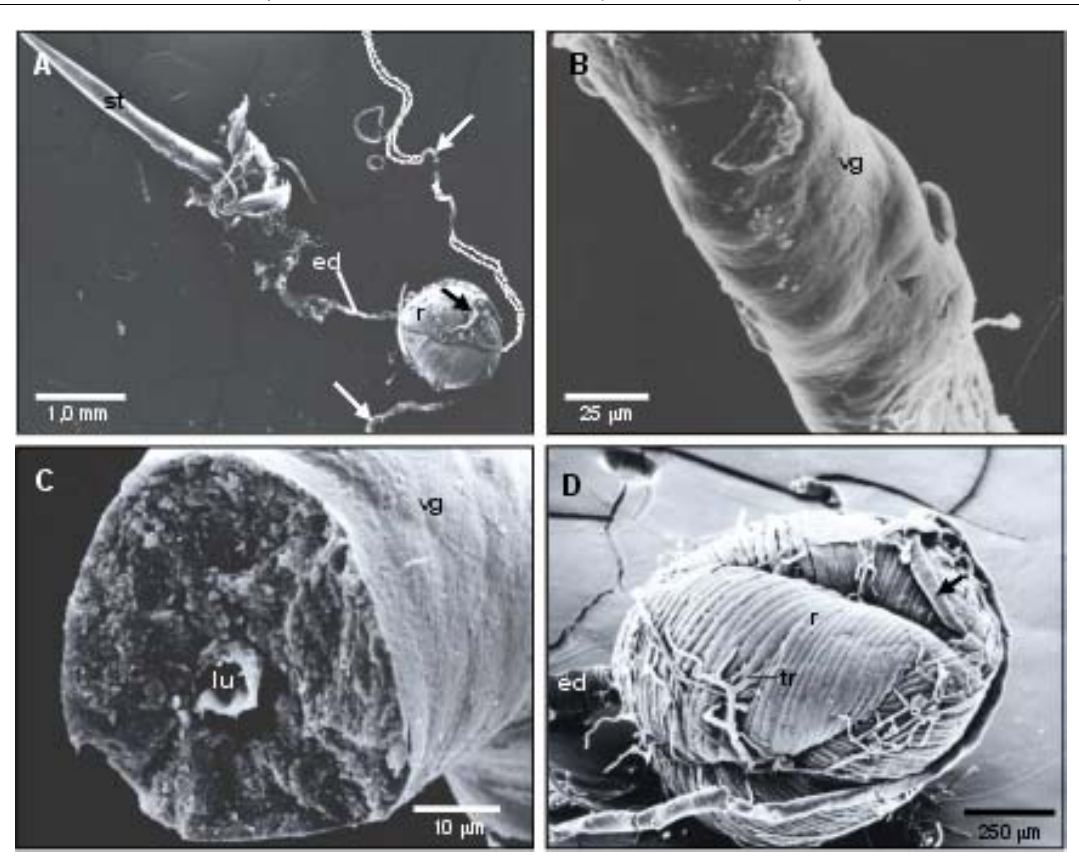
Figure 1 – (A) General view of the venom glands (arrows), reservoir, excretory duct, and sting; (B) Detail of the venom gland; (C) Venom gland penetrating its reservoir (arrow); (D) Broken region of the venom gland showing its lumen. ed - excretory duct; lu - lumen; r - reservoir; st - sting; tr - trachea; vg - venom